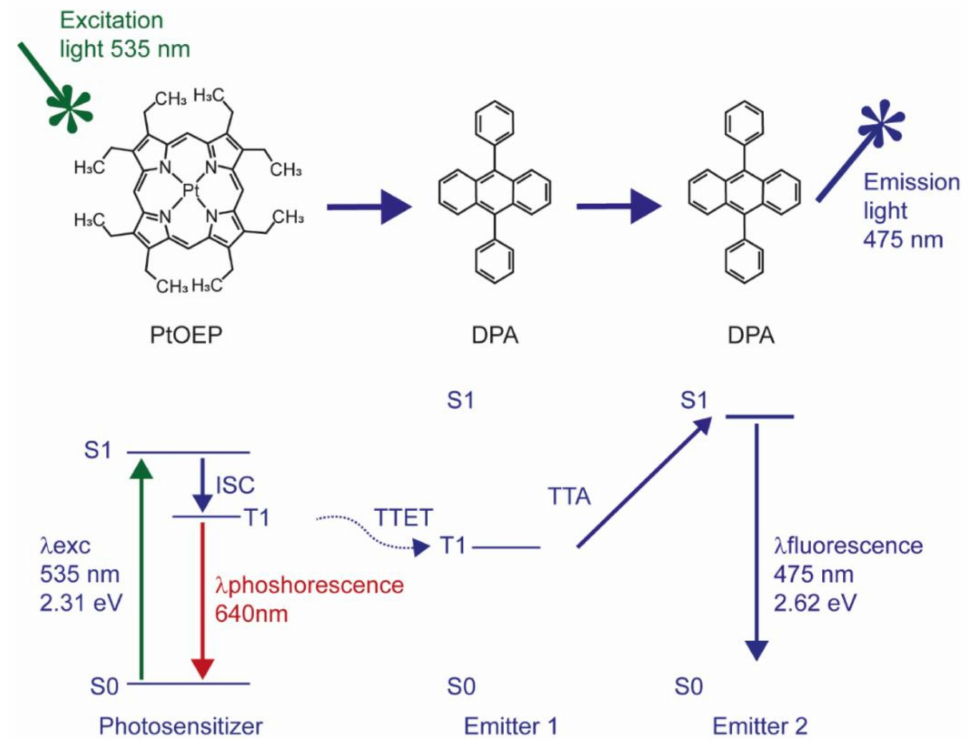
Figure 1. Jablonski diagram describing the energy levels of the electrons involved in energy transfer between PtOEP and DPA molecules. The energy values are calculated based on theoretical data. When electromagnetic radiation “hits” a sensitizer molecule, its electrons will be promoted from the ground to a singlet excited state and then transferred to a triplet excited state nonradiatively. The released energy that accompanies the transition of the triplet excited electron to the ground singlet state will be transferred to an emitter/acceptor molecule to pump the latter to an excited triplet state. If two of these triplet excited state molecules are close enough, the interaction between the two will cause the transition of one of them to the ground singlet state and the other to a singlet excited state, i.e., the collision results in an annihilation of the triplet excited state of one acceptor molecule and promotion of another one to the singlet excited state (Figure